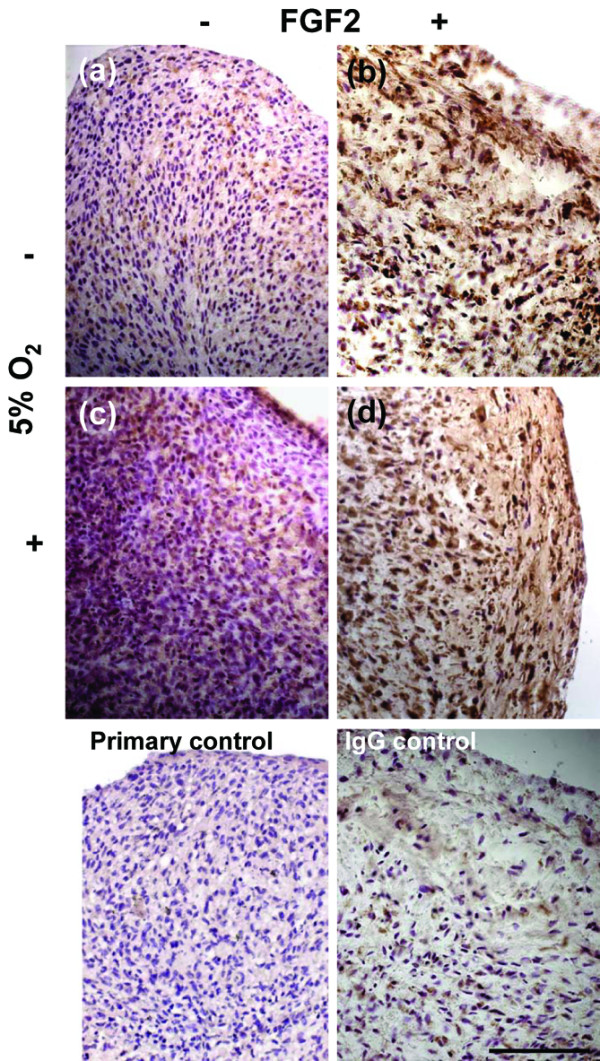
Immunolocalisation of type I collagen in cell aggregates after 14 days of culture. Cell aggregates derived from meniscus cells expanded in the absence ((a) normoxia; (c) hypoxia) and presence ((b) normoxia; (d) hypoxia) of fibroblast growth factor 2 (FGF2). No primary antibody control and non-specific IgG control. Scale bar, 100 μm.